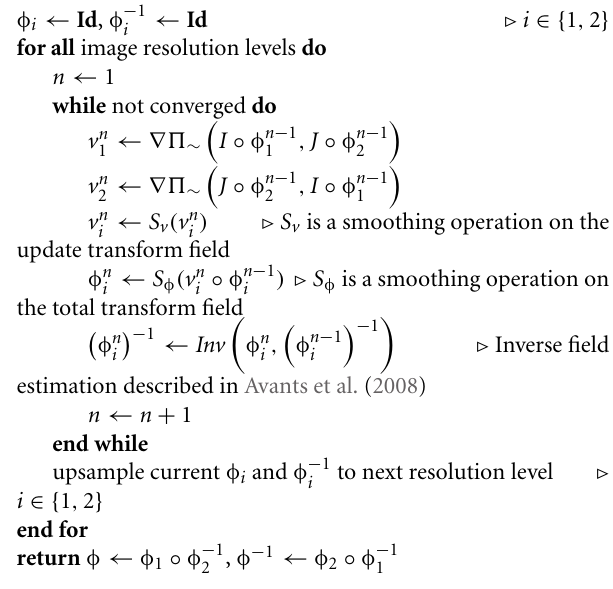
Algorithm 1 | Greedy SyN